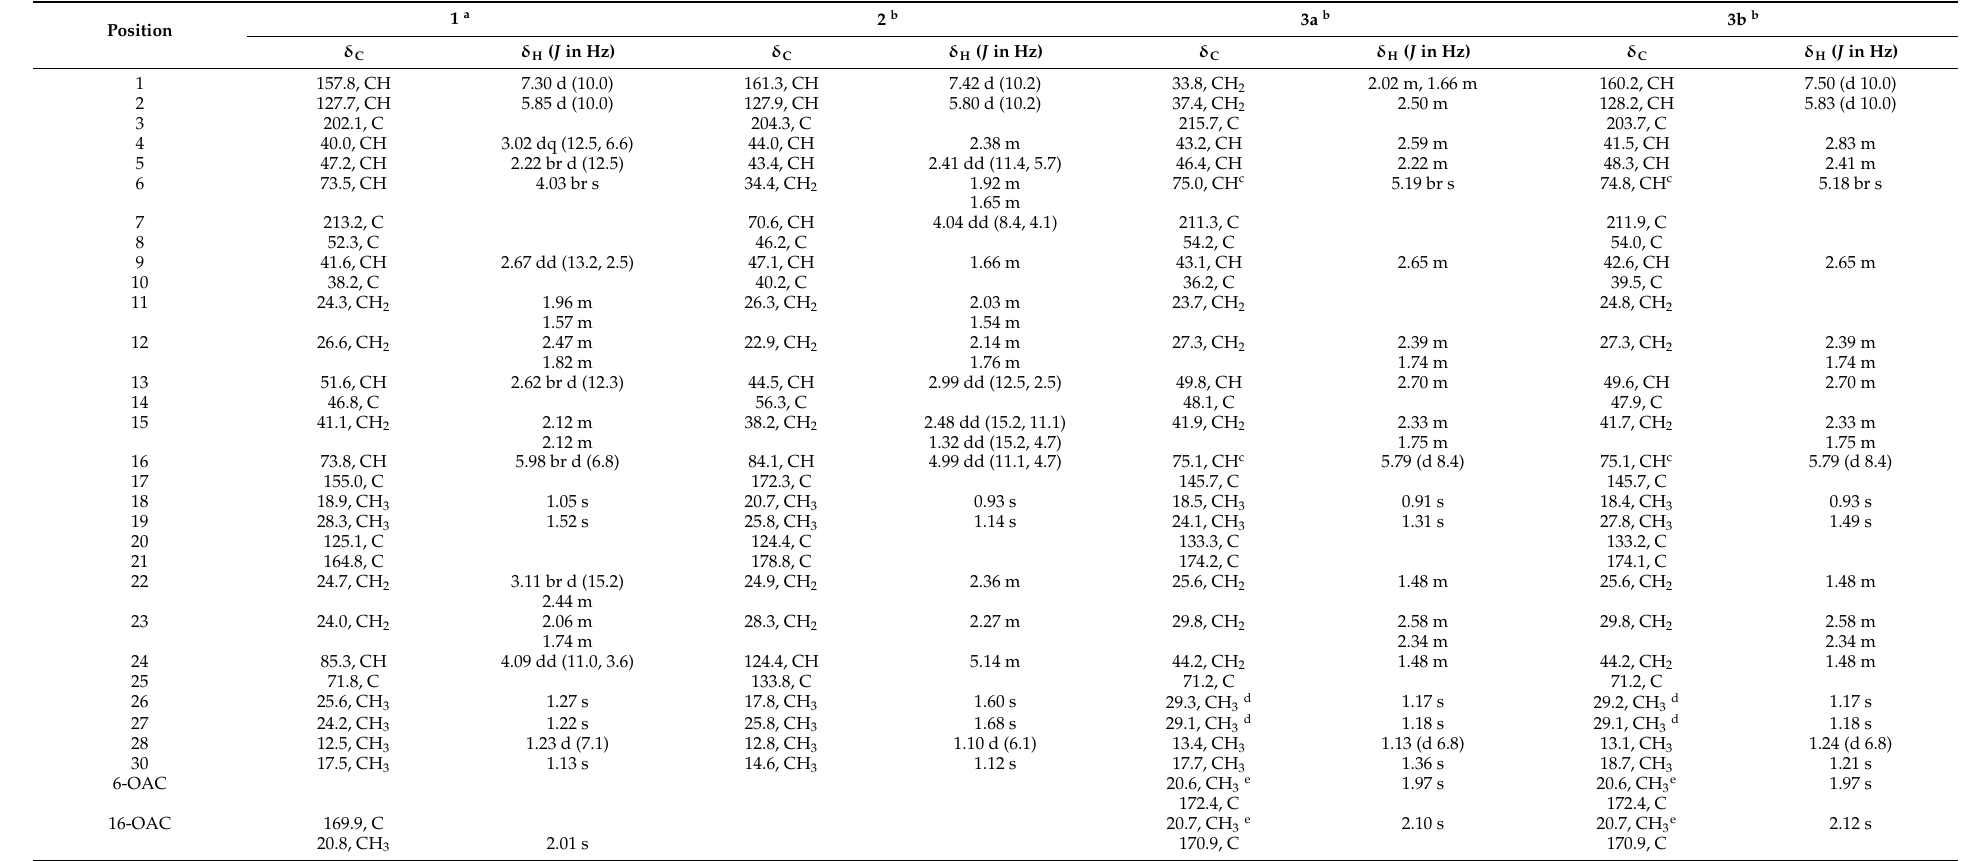
Table 1. 1 H (400 MHz) and 13 C NMR (100 MHz) data of compounds 1 – 3